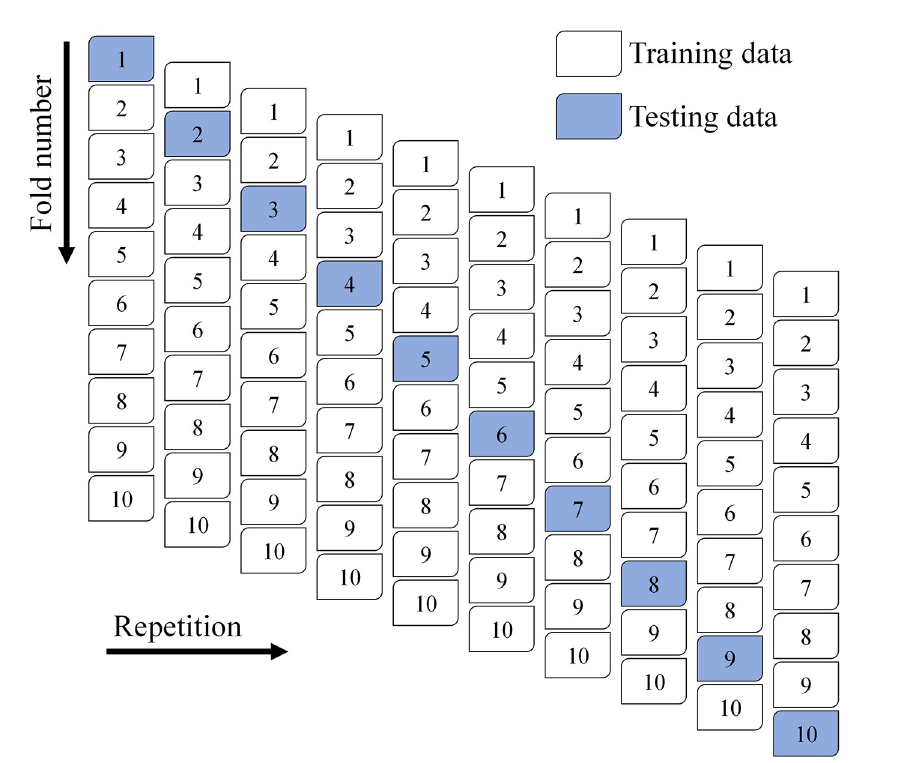
Fig 5. Schematic illustration of k-fold